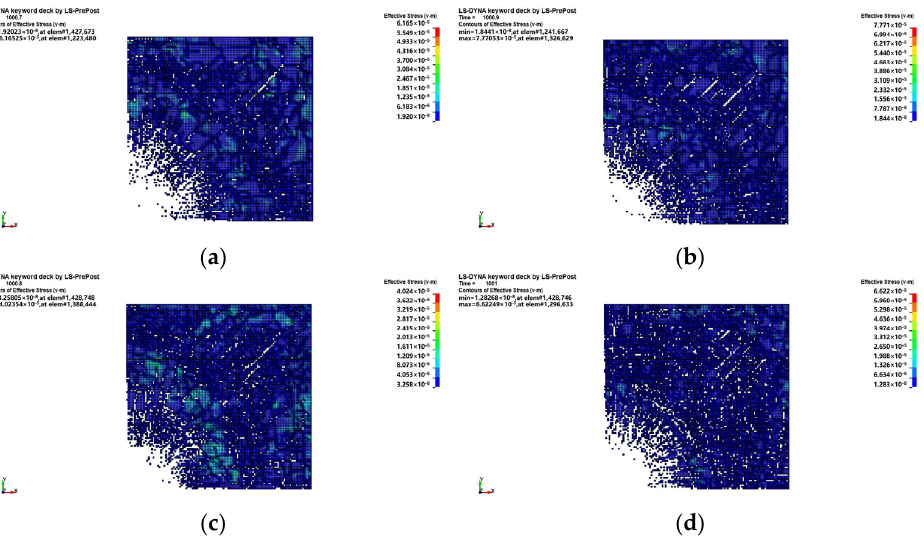
Figure 6. ( a ) Blasting with 3.2 kg TNT; ( b ) blasting with 4.8 kg TNT; ( c ) blasting with 6.4 kg TNT; ( d ) blasting with 8.0 kg TNT.